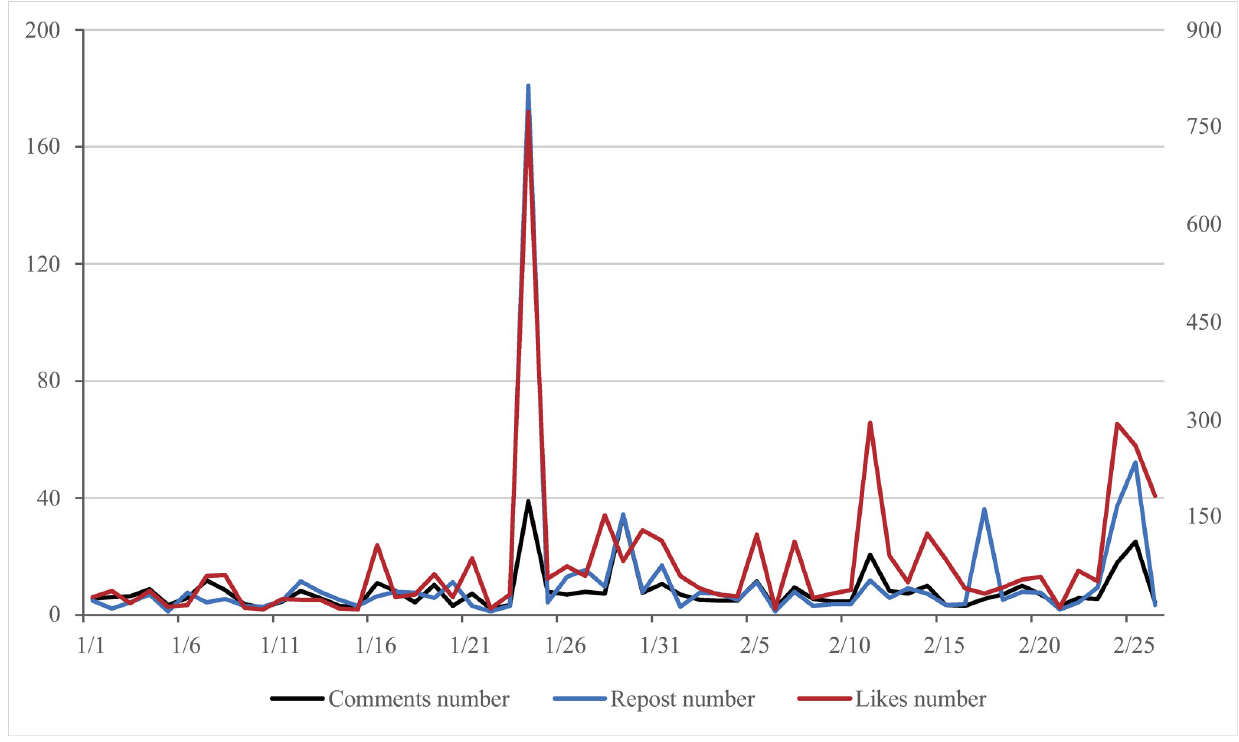
Fig 2. Time series analysis of Weibo discussion